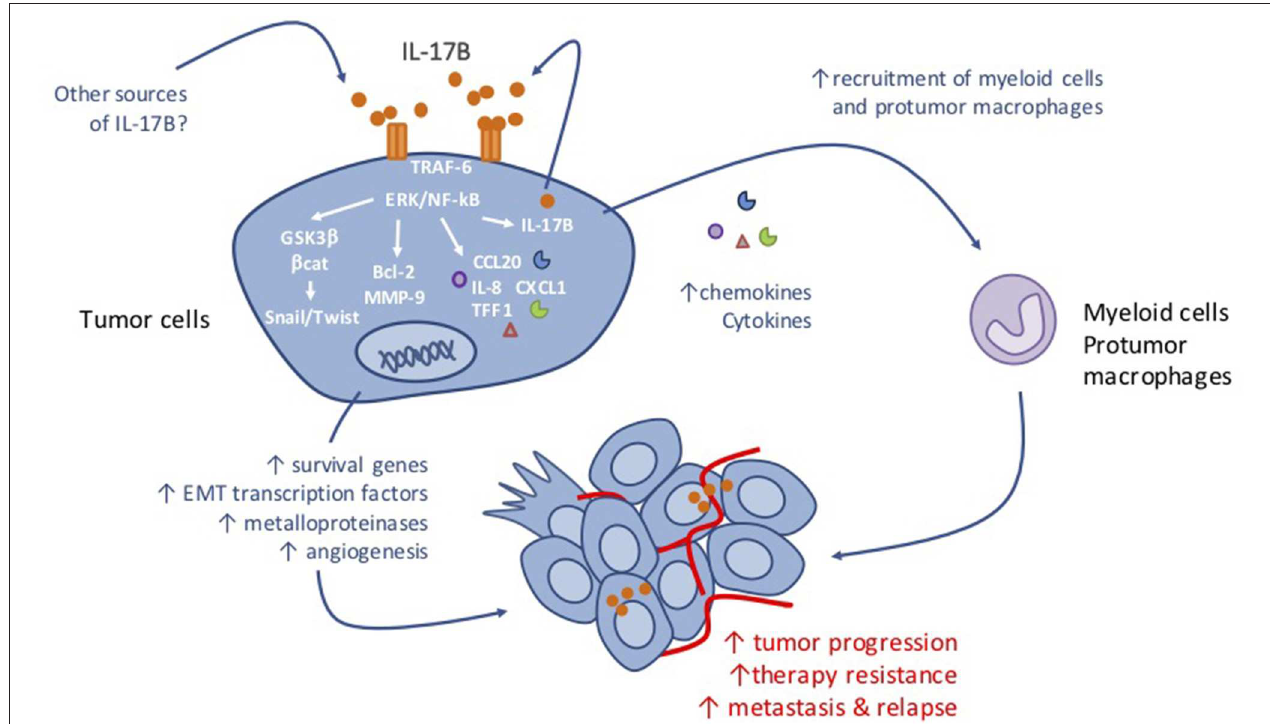
FIGURE 1 | Anticipated mechanism of action of IL-17B in